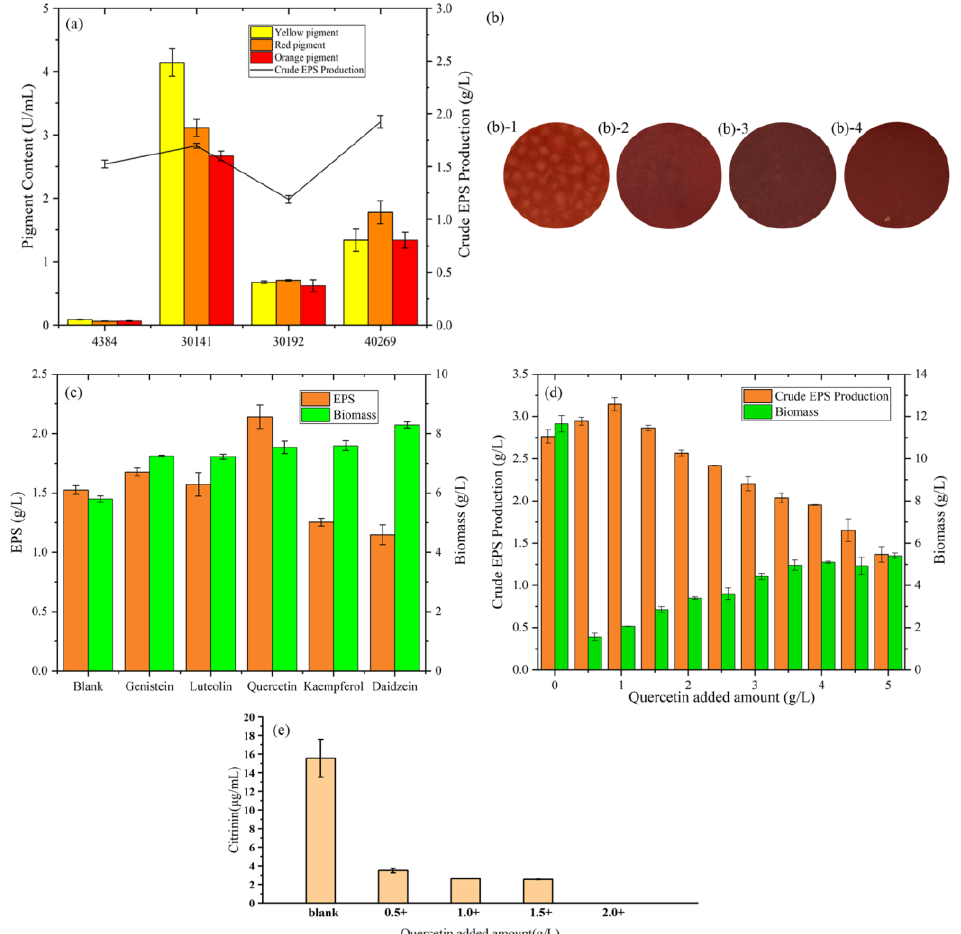
Figure 1. ( a ) Comparison of the extracellular pigment and crude EPS changes of four Monascus strains. ( b ) Growth diagram of four strains of Monascus : ( b-1 ) represents Monascus aurantiacus AS3.4384, ( b-2 ) represents Monascus purpureus 30141, ( b-3 ) represents Monascus anka 30192, ( b-4 ) represents Monascus purpureus 40269. ( c ) Effects of the addition of flavonoids to Monascus aurantiacus AS3.4384 on the production of crude EPS and biomass. ( d ) Effect of different addition of quercetin on Monascus aurantium AS3.4384 on the production of crude EPS and biomass. ( e ) The production of citrinin after adding quercetin to Monascus aurantium AS3.4384 in the sucrose yeast extract medium for 4